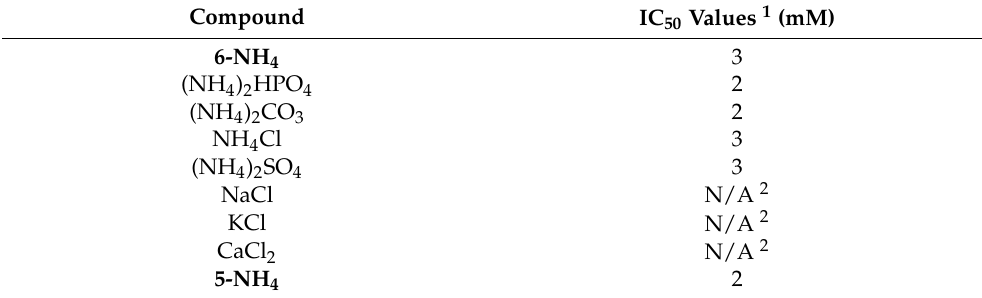
Table 2. IRI activity of ammonium phosphonate derivatives of 5 and 6 and inorganic salts.